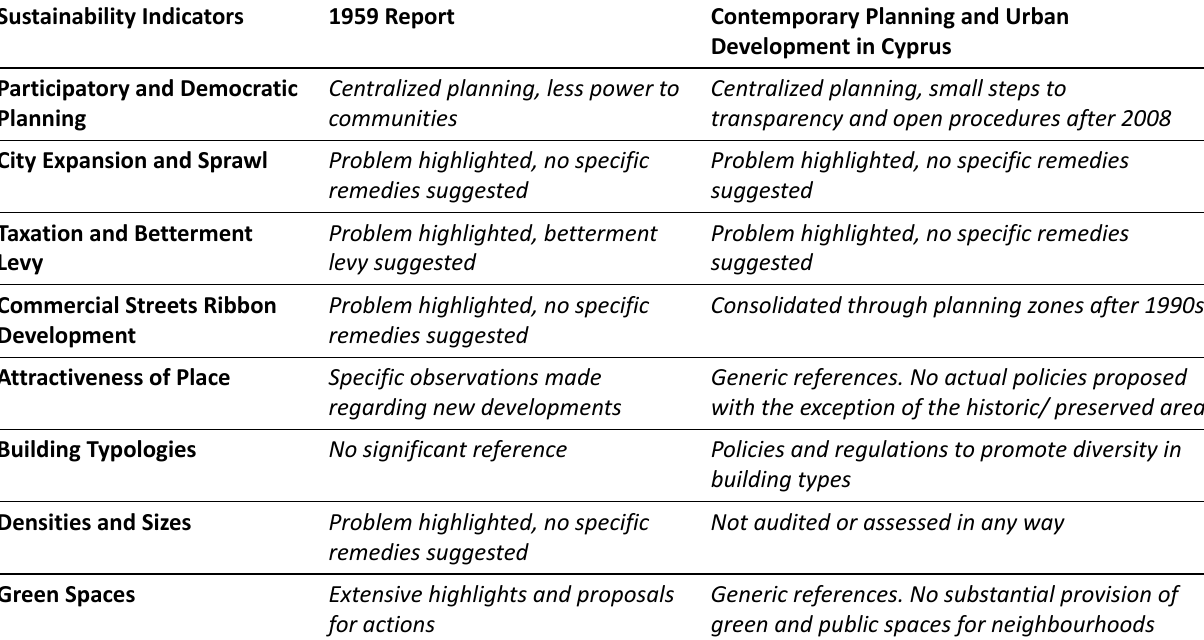
Table 1. Relation of the shortcomings of 1959 Report to contemporary planning and suburban development in